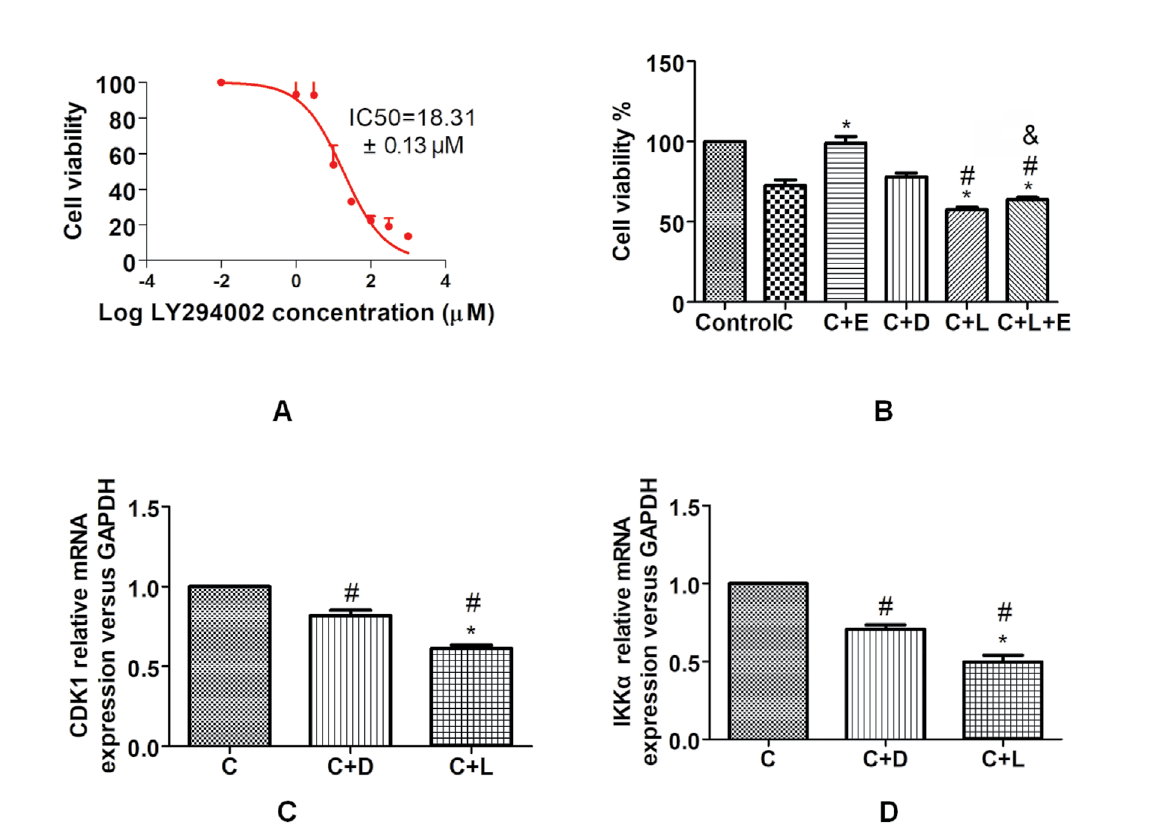
Figure 4 – The intervention effect of EPO on U251 cells under hypoxia through PI3K signaling pathway. (A) The IC50 concentration of the inhibitor LY294002. (B) The cell viability of effect of EPO on U251 cells. # P<0.05 vs. the CoC1 +EPO group. ( C, D) The effect of inhibition of PI3K expression on IKK α and CDK1 transcription level under hypoxia.#P<0.05 vs. the CoC1 the CoC1 2 group.* P<0.05 vs. the CoC1 +DMSO group, Newman-Keuls multiple comparisons 2